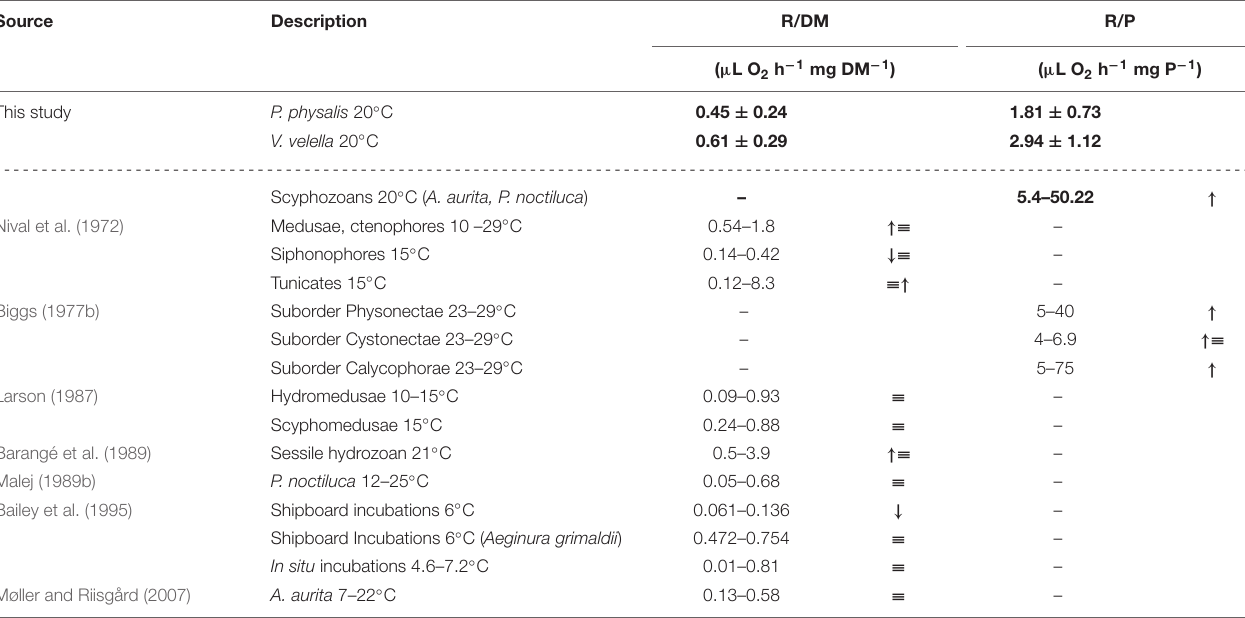
TABLE 7 | Dry mass (DM) specific and protein (P) specific physiological respiration (R) results for P. physalis and V. velella studied are presented as mean ± SD.